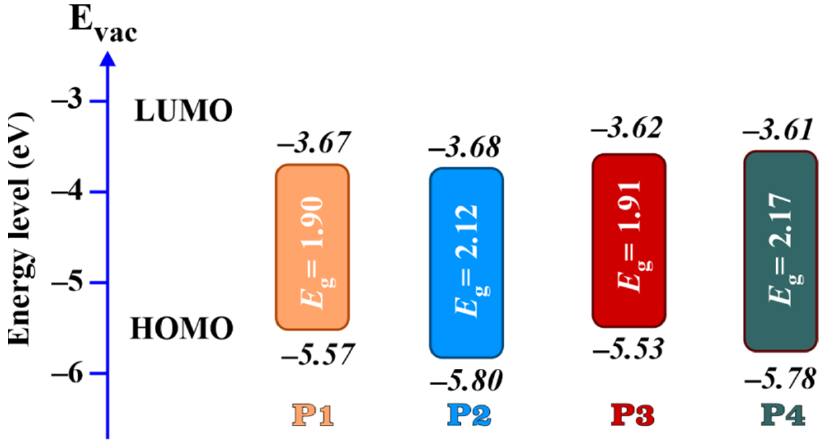
Figure 7. HOMO, LUMO and bandgap energy diagram of P1 – P4 .